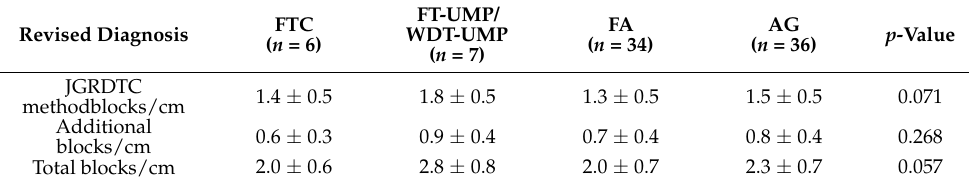
Table 5. Number of tissues blocks per 1 cm of tumor based on revised diagnoses. Revised